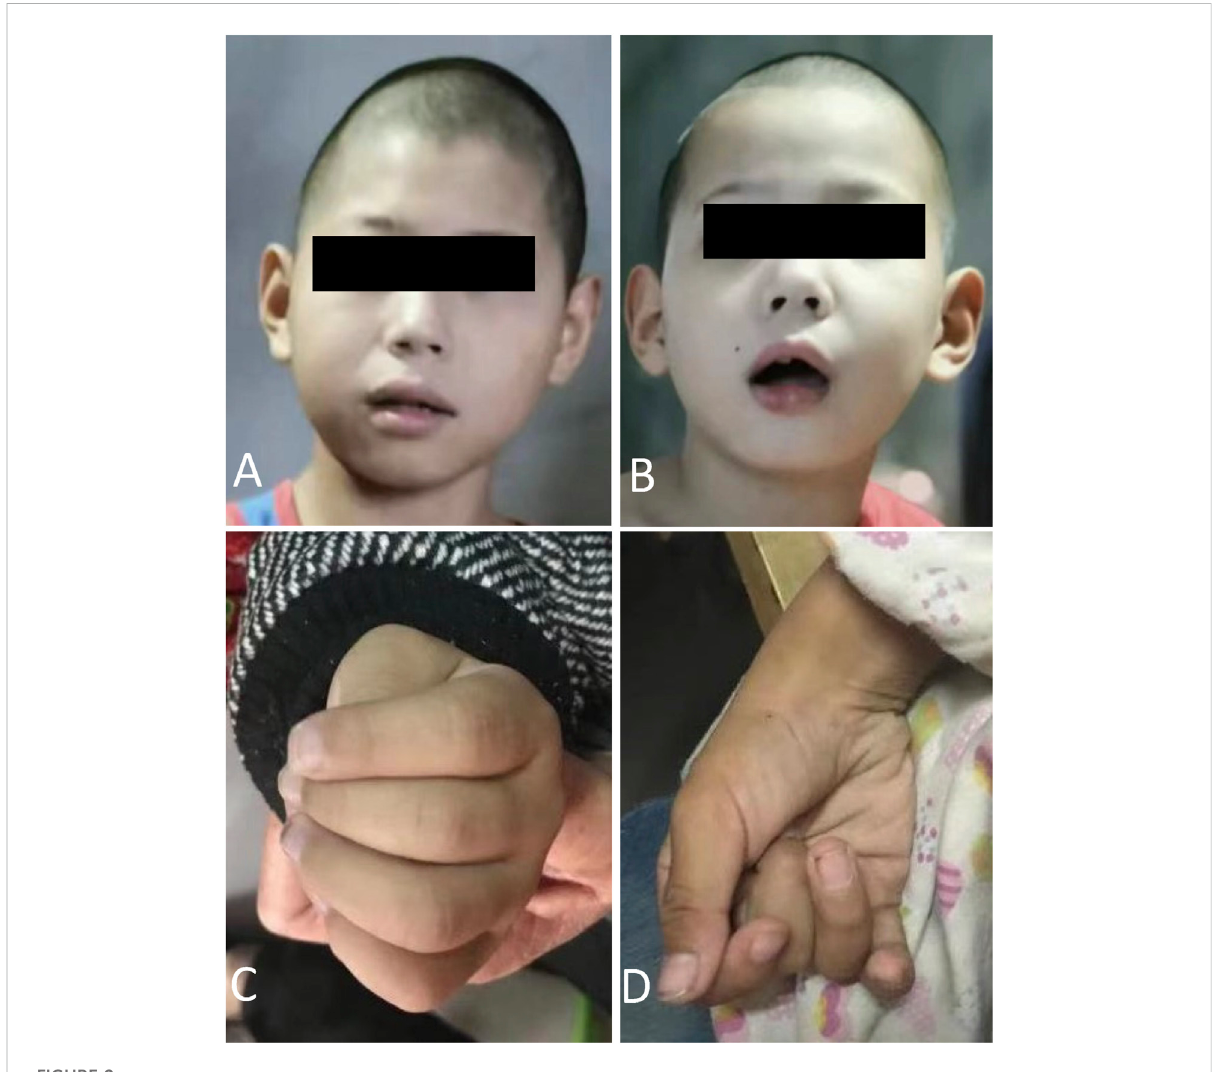
FIGURE 2 Facial features and involuntary fl exion of fi ngers (III1 and